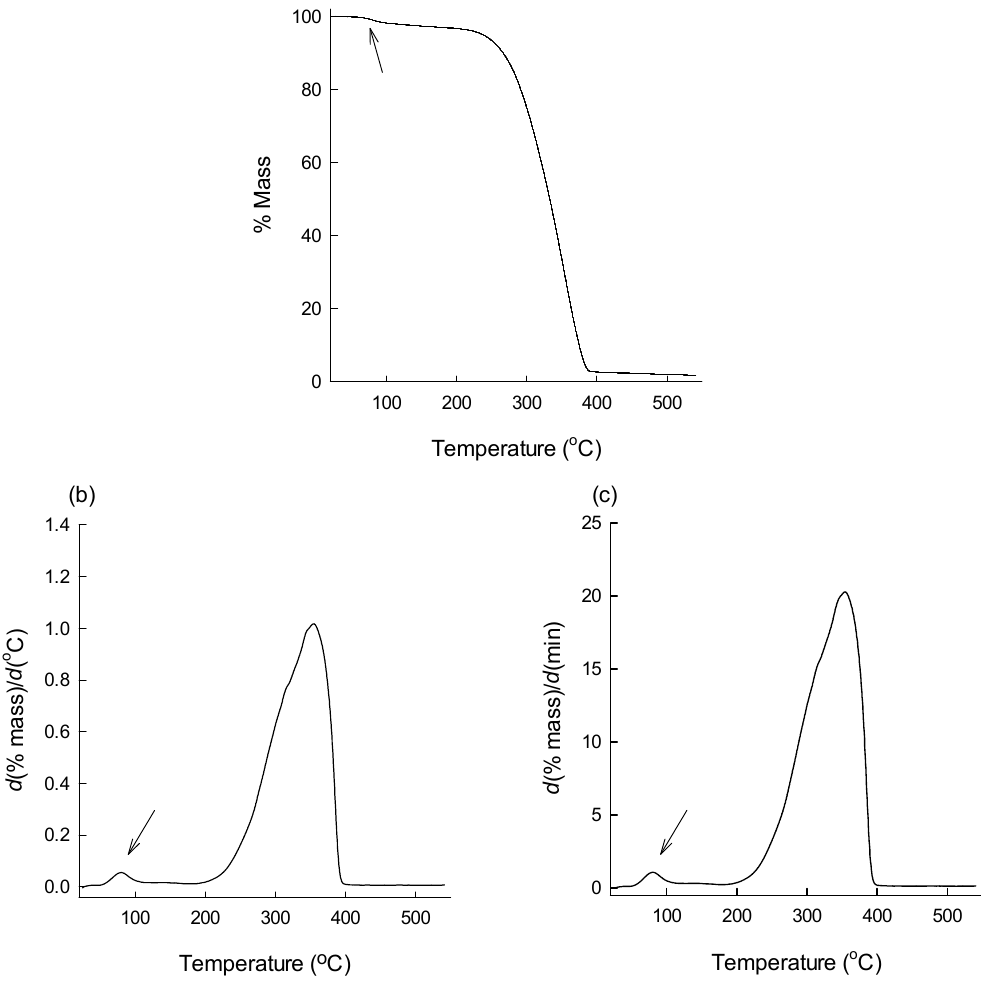
Figure 4. Typical ( a ) thermogravimetry (TG) and ( b , c ) derivative thermogravimetry (DTG) curves of PLGA microspheres. The first derivative of a TG curve was established with respect to ( b ) temperature and ( c ) time. A thermal event arising from the evolvement of residual ethyl formate in the microspheres is clearly demonstrated as the first peaks in the DTG curves.